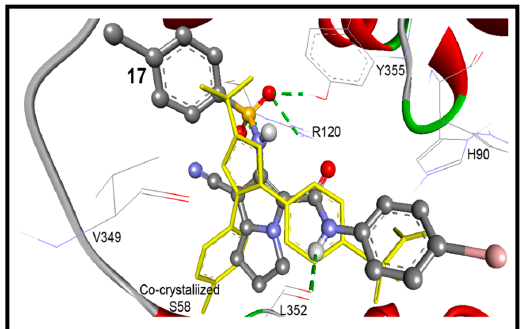
Table 4. Compound 17 conserved four hydrogen bonds between its sulfonamide and aniline NH moieties and NH 2 of Arg120, phenolic OH of Tyr355, and carbonyl group of Leu352, Figure 10.